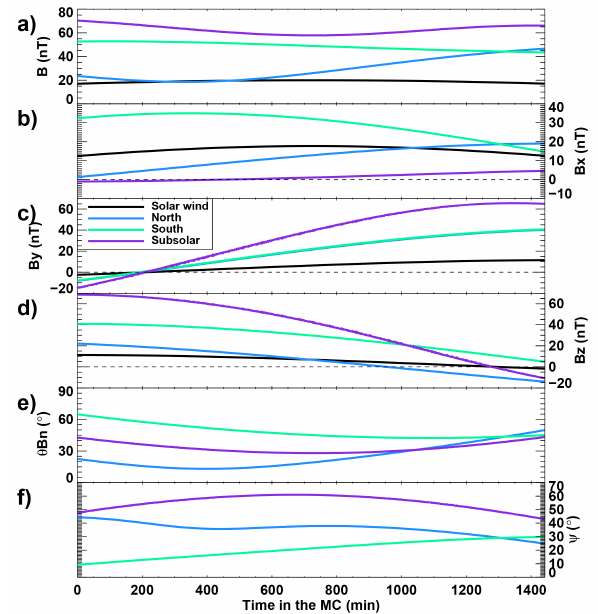
Fig. 10. Virtual spacecraft observations of the magnetosheath mag- netic field during an oblique MC. See the caption of the panel B of Fig. 7 for